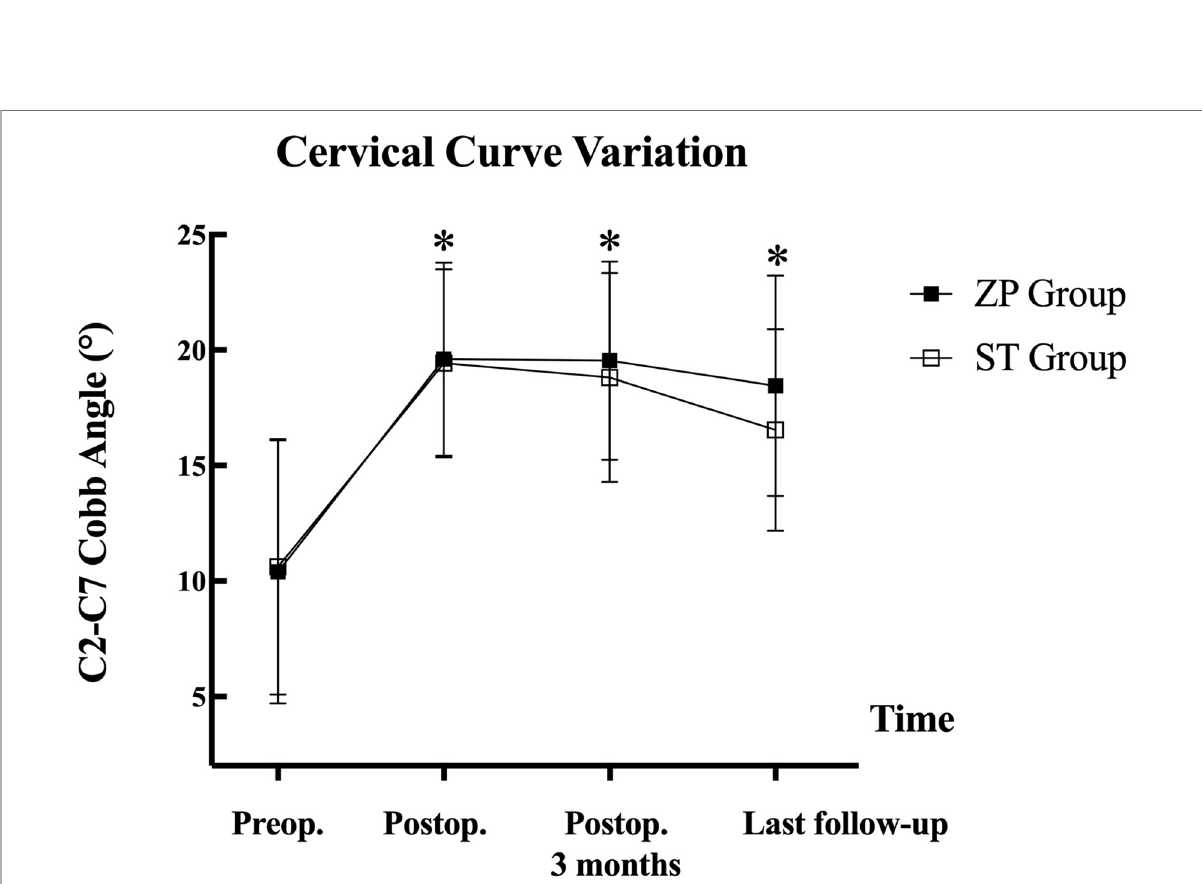
FIGURE 3 Variation of C2 – C7 Cobb angle during the follow-up for ZP group and SC group. ZP, zero-P cage; ST, stand-alone cage; Preop, preoperative; Postop, postoperative. * P <0.05, compared with preoperative